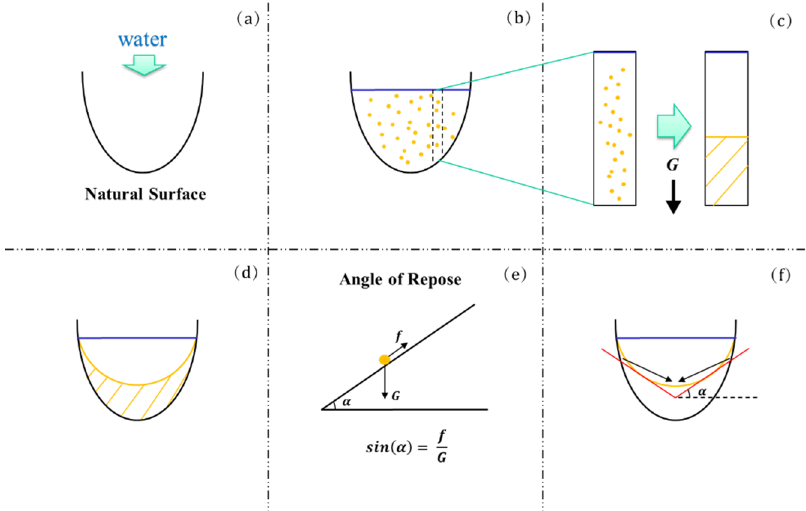
Figure A1. The common process of how a lake is formed. The black line represents the natural surface; the yellow line / points represent the sediment surface / material; and the blue line represents the water surface.